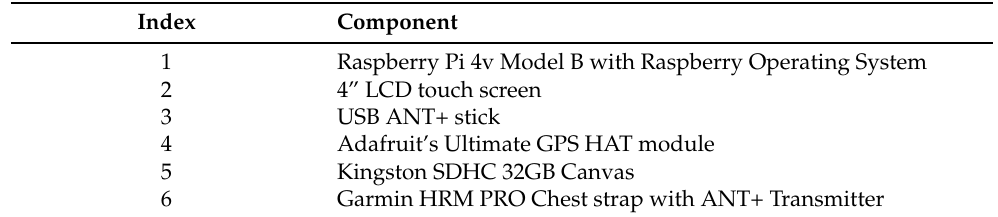
Table 2. Specifications of the hardware